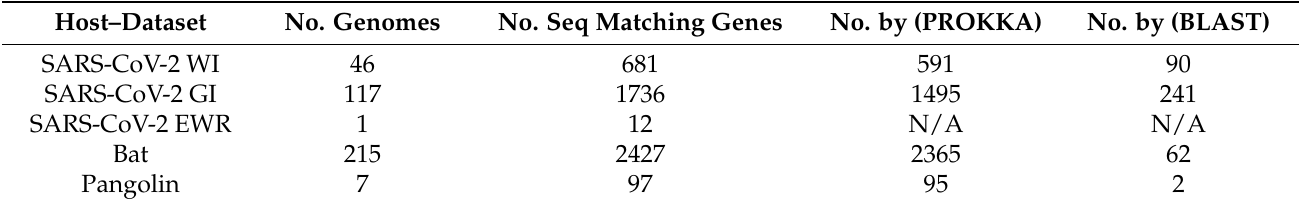
Table A3. Table containing the total number of genomes and sequences matching genes for each host species group. Gene sets listing number of sequences matching genes identified by either PROKKA or BLAST. SARS-CoV-2 group names shortened as; WI: Wuhan Isolates, GI: German Isolates, EWR: Ensembl Wuhan Reference. Listed is the total number of all PROKKA genes identified and the number of BLAST genes which matched an Ensembl reference gene with 80% percentage identity.